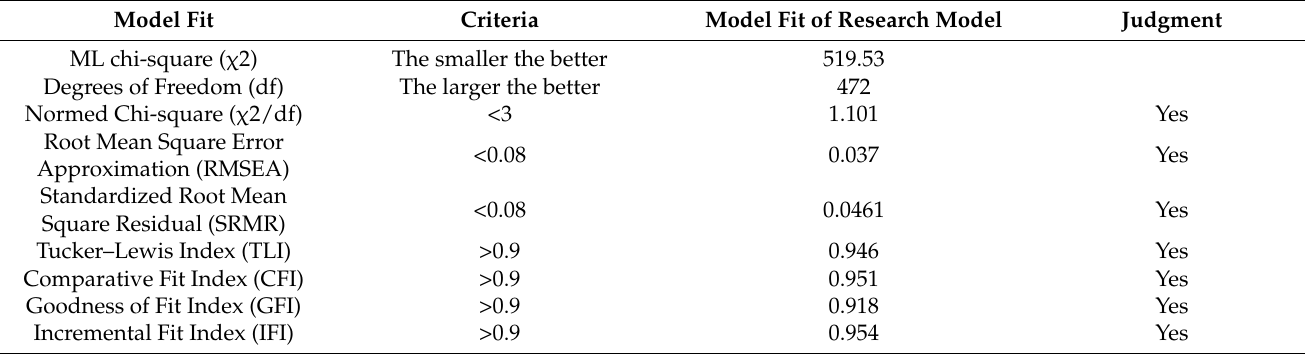
Table 8. Model fit